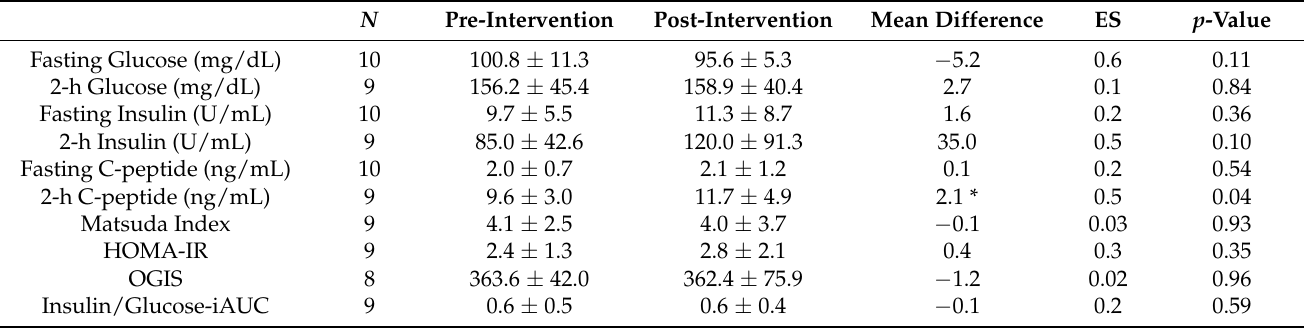
Table 3. Metabolic marker pre-post changes.